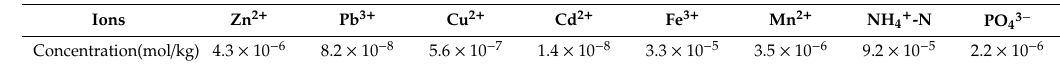
Table 10. Initial concentration of chemical